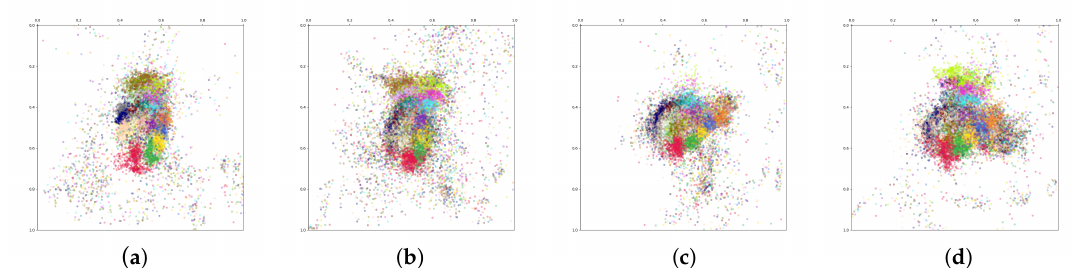
Figure 32. Aggregated joint positions for gestures: ( a ) palm, ( b ) two fingers (V), ( c ) thumb, ( d ) three fingers.